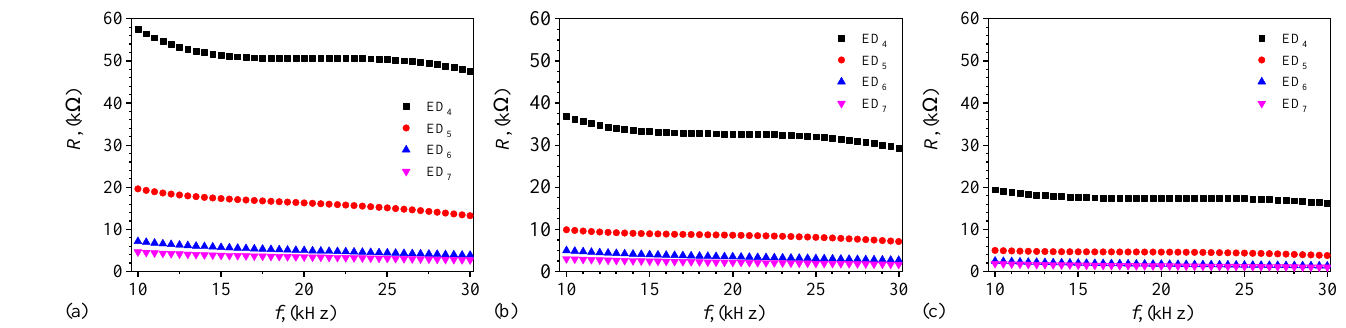
Figure 12. Variations in resistance R with the frequency f of a sinusoidal electric field at discrete values of the magnetic flux density B . ( a ) B = 0 mT. ( b ) B = 200 mT. ( c ) B = 400